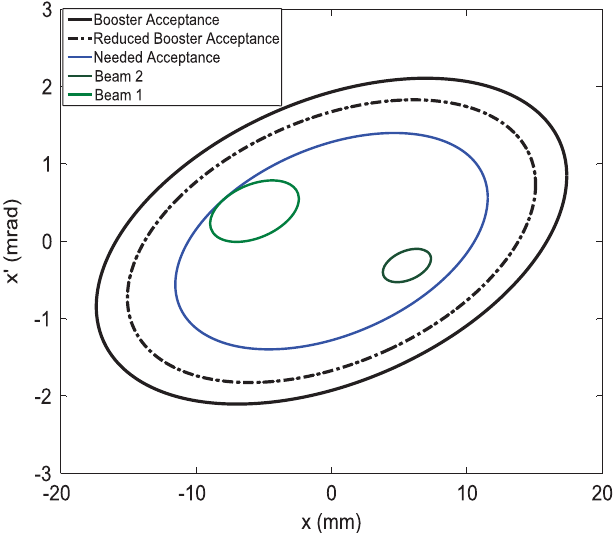
FIG. 15. The acceptance of the booster with injection and closed orbit